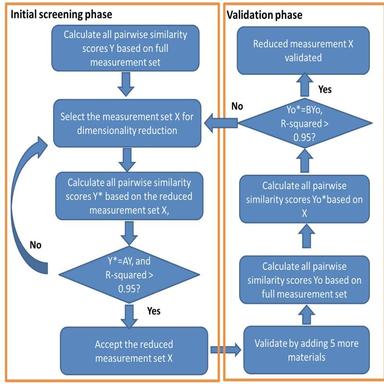
The flowchart describing the proposed methodology to reduce the dimensionality of the material library.